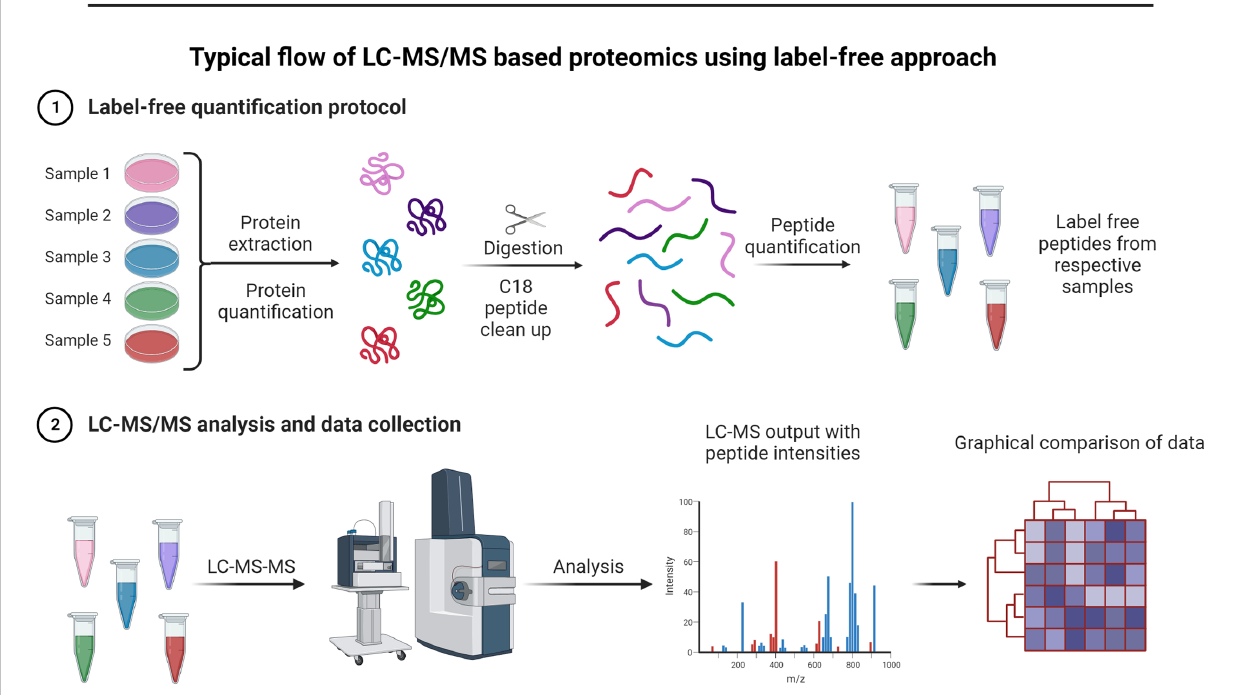
FIGURE 8 Example of proteomics work fl ows. Top fi gure: Biological samples such as tumors, cells, tissues, and secreted media are processed to extract the proteins. Extracted proteins are digested and analyzed by LC-MS/MS. Raw fi les generated from LC-MS/MS are used in a proteomics database search engine for protein identi fi cation and quantitation. Bottom fi gure: tandem mass tag (TMT) labeling is used to perform multiplex analysis for simultaneous relative quanti fi cation of proteins and for identi fi cation (149,